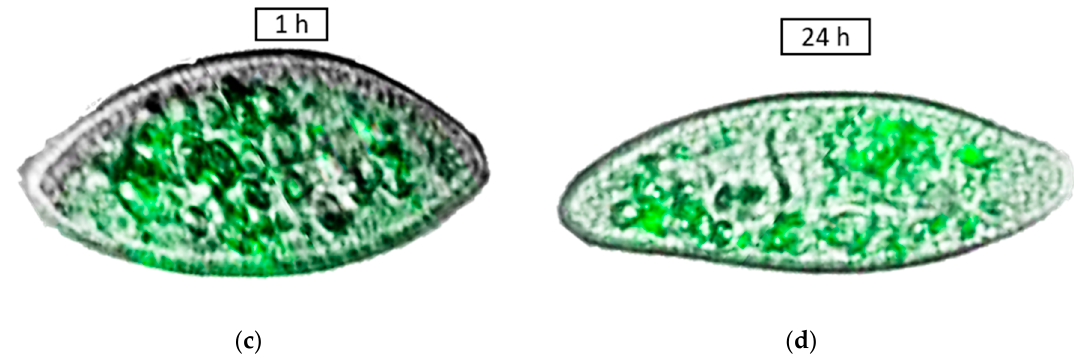
Figure 31. Fluorescence-based measurement of accumulation of cadmium telluride quantum dots (CT QDs) in Paramecium cells. Superimposed (fluorescence and bright field) images of ( a ) and ( b ) control Paramecium (exposed with E. coli ) at ( a ) 1 and ( b ) 24 h; and ( c ) and ( d ) of treated Paramecium ( E. coli + QDs) at ( c ) 1 h and ( d ) 24 h. (Modified after [148] ).